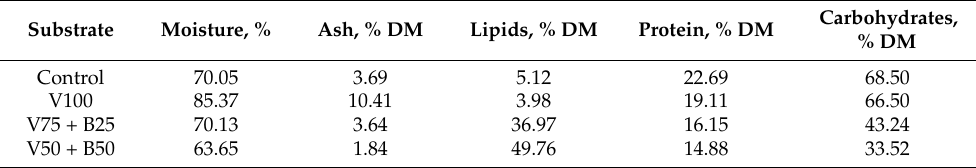
Table 1. Substrate chemical composition.